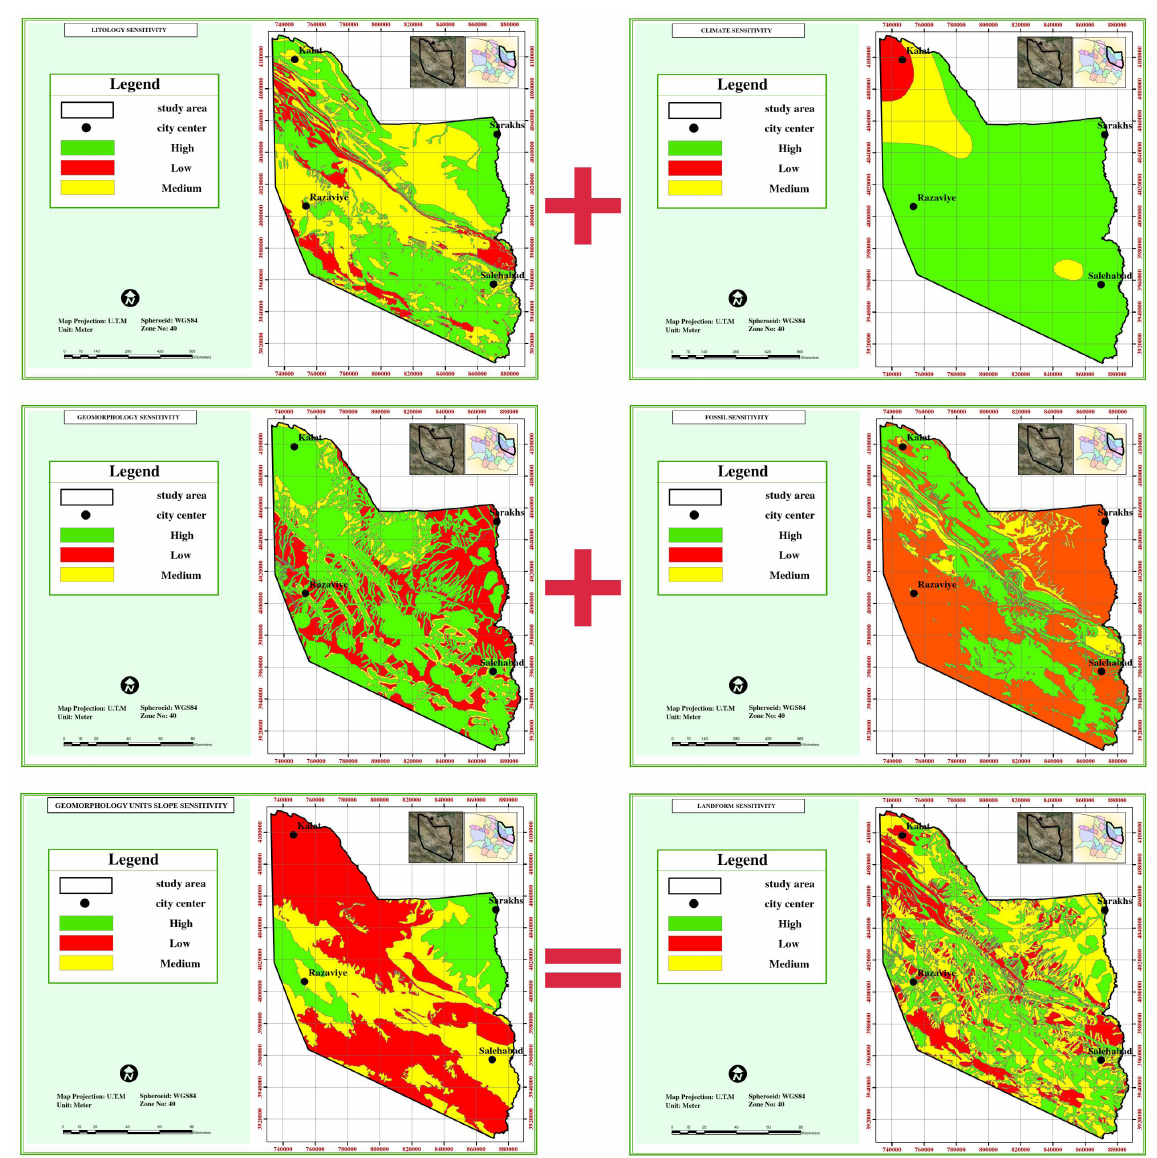
Figure 5. Overlay of the sub-criteria maps used in the preparation of the sensitivity